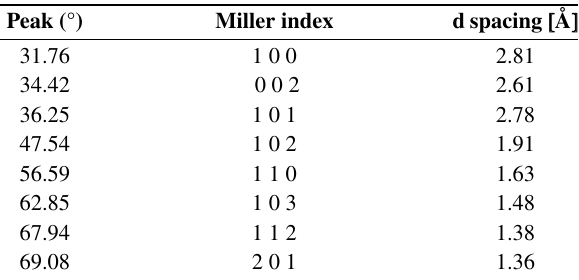
Table 4. Miller indexes and d-spacings of obtained zinc oxide Peak (°)